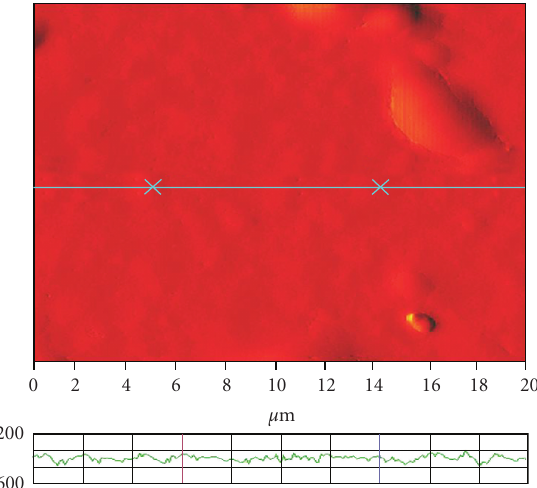
Figure 9: An AFM image of a 16 PDMS-1/PDMS-2 bilayered film prepared from water solutions after a 2-hour heating at 180 ◦ C.